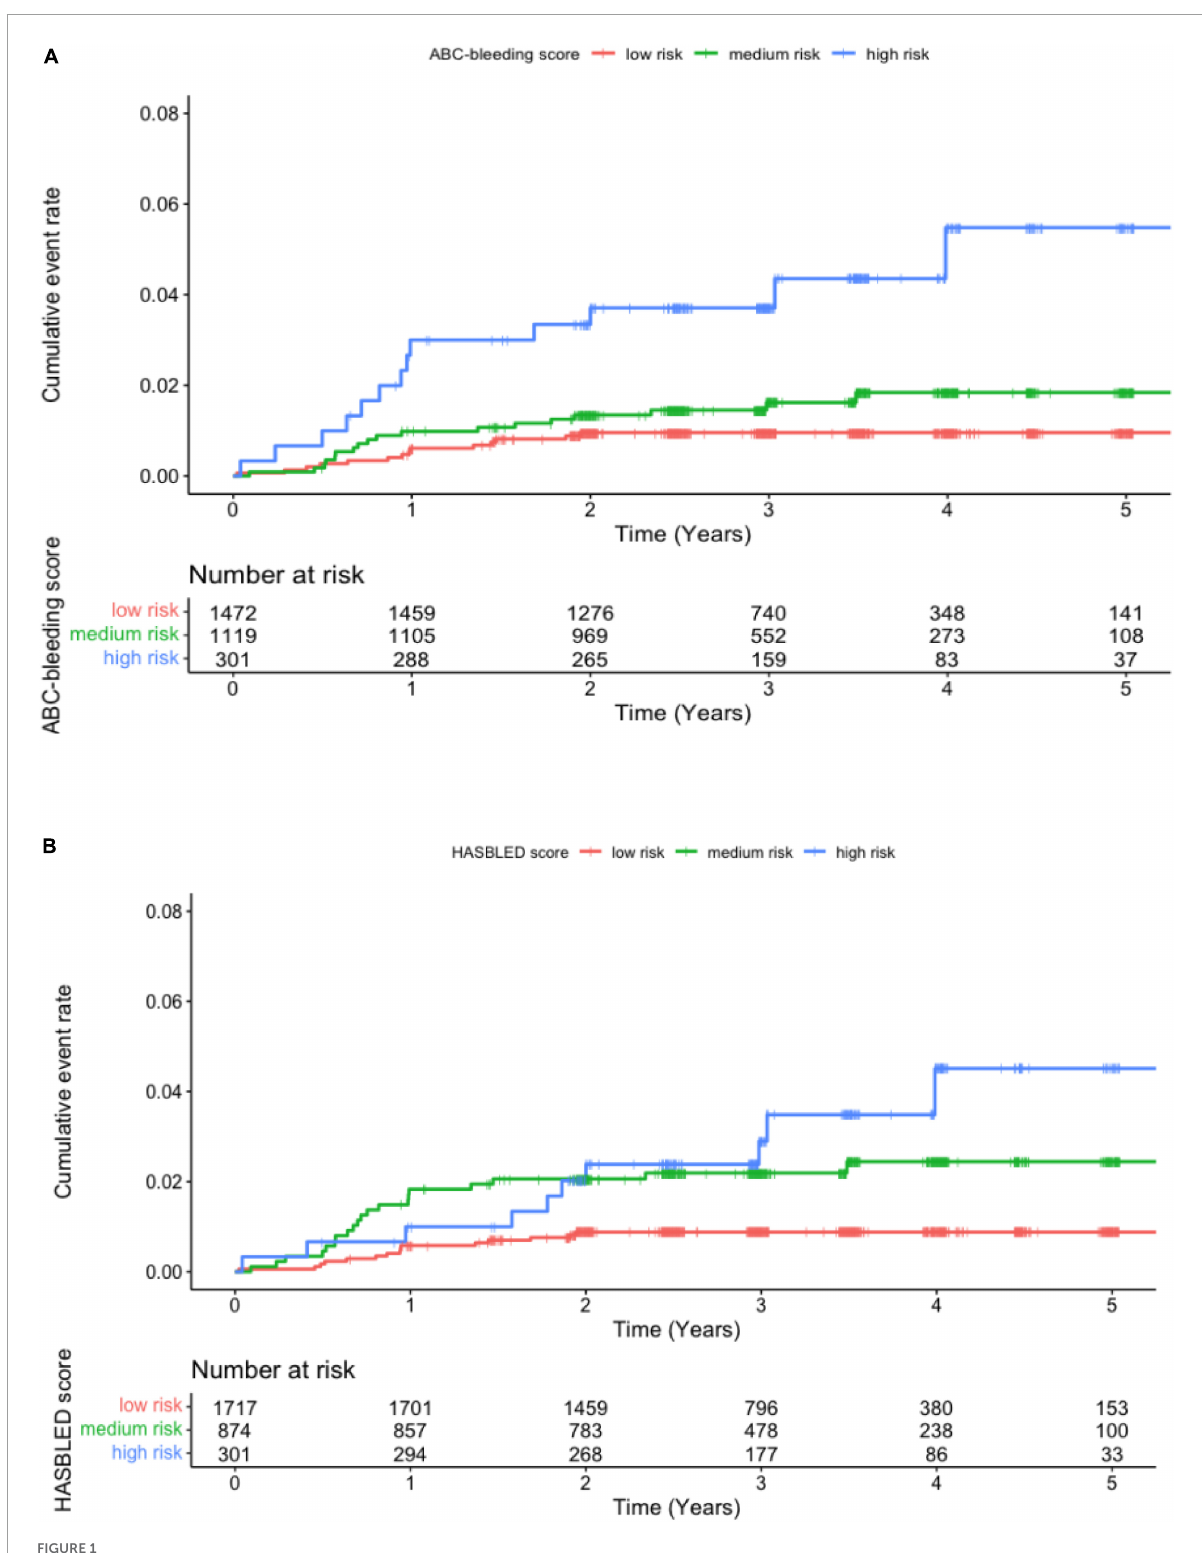
Frontiers in Cardiovascular Medicine